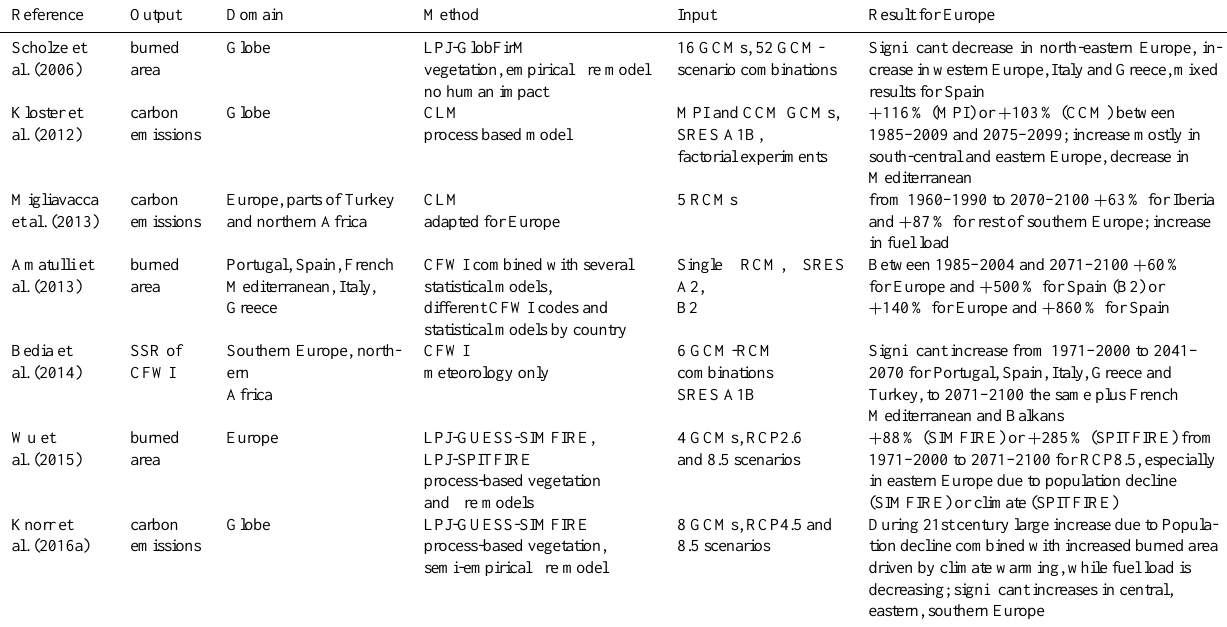
Table 1. Overview of climate change modelling results for wildfires that cover